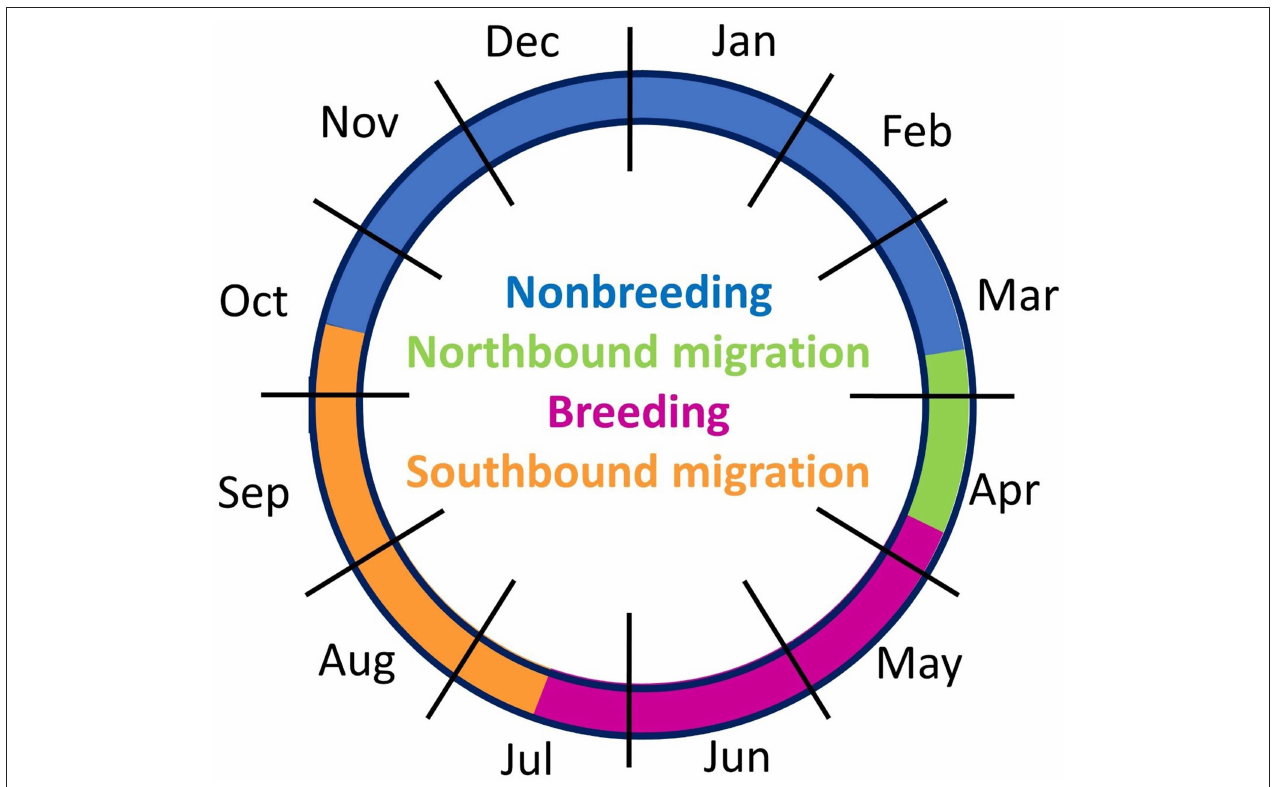
FIGURE 6 | Annual cycle based on movement tracking of nine migratory Upland Sandpipers in the Western Hemisphere, May 2016 to May 2017. The four periods of the annual cycle were based on the median dates of transition between consecutive